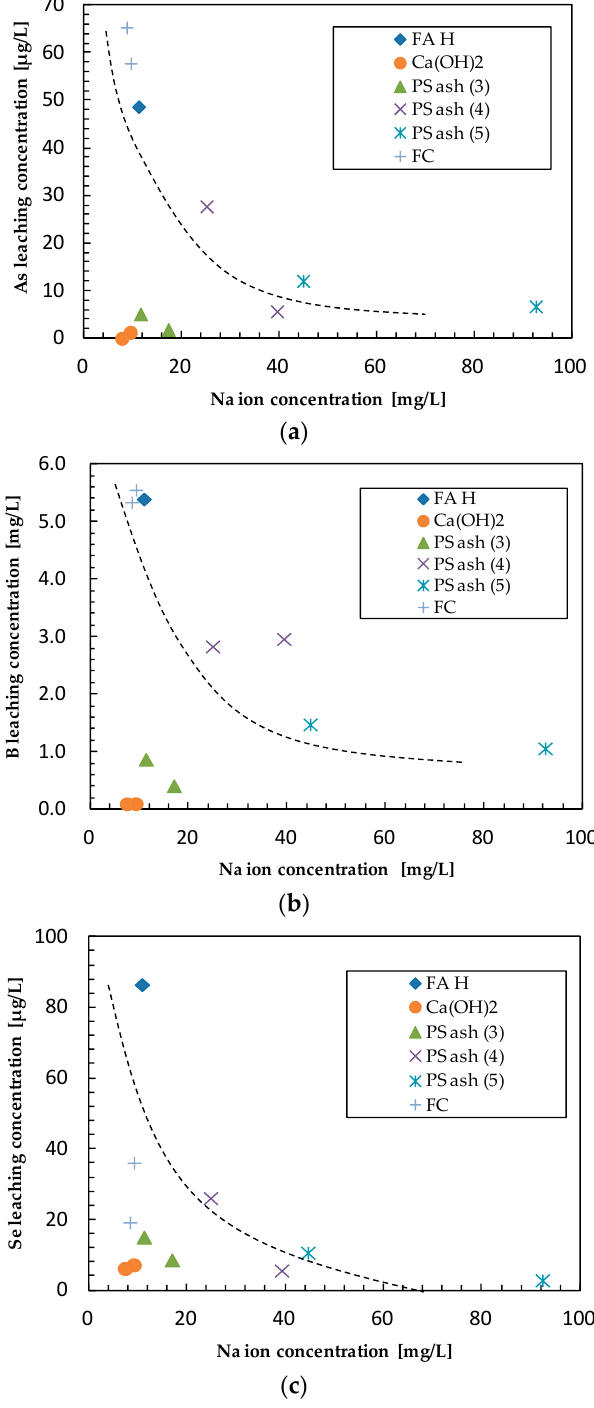
Figure 8. Relationship between the Na ion leaching concentration and trace elements leaching concentration of five kinds of additives: ( a ) arsenic; ( b ) boron; and ( c ) selenium.